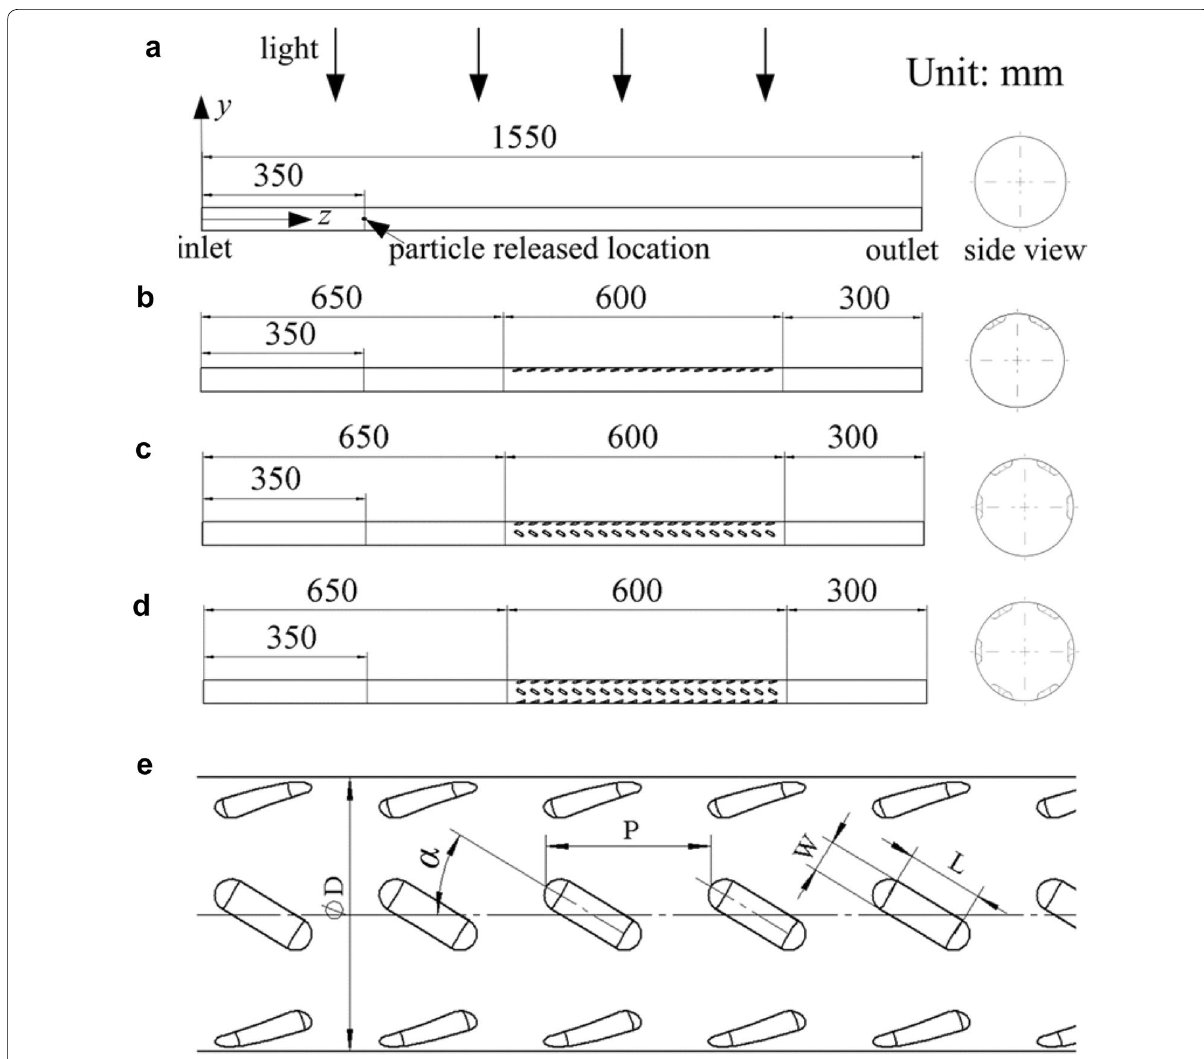
Fig. 1 a Smooth tubular PBR, named Type-0; b tubular PBR with a pair of ribs, named Type-1; c tubular PBR with two pairs of ribs, named Type-2; d tubular PBR with three pairs of ribs, named Type-3; e the detail of the ribs. Particles are released at z been fully developed (Gómez-Pérez et al.